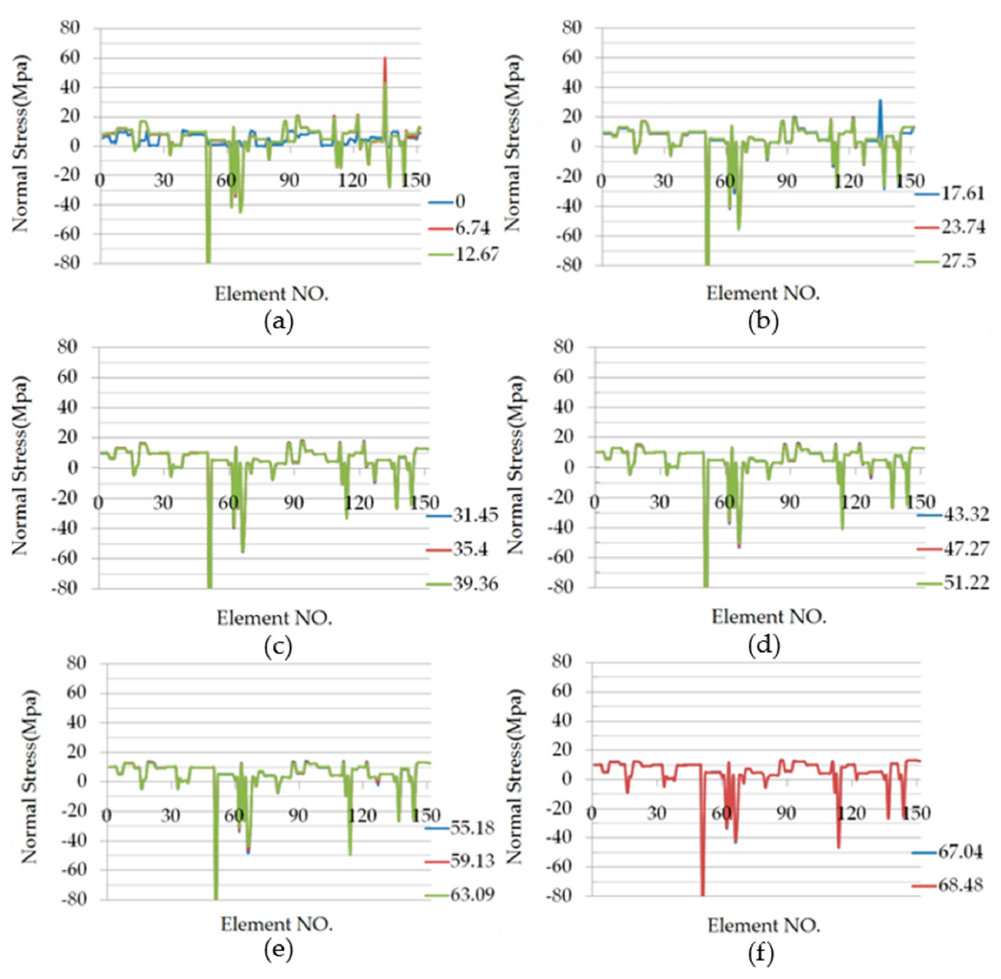
Figure 16. Evolution of normal stress of all grain boundary elements at the same time. ( a ) Time: 0 h, 6.74 h, 12.67 h. ( b ) Time: 17.61 h, 23.74 h, 27.5 h. ( c ) Time: 31.45 h, 35.4 h, 39.36 h. ( d ) Time: 43.32 h, 47.27 h, 51.22 h. ( e ) Time: 55.18 h, 59.13 h, 63.09 h. ( f ) Time: 67.04 h, 68.48 h.